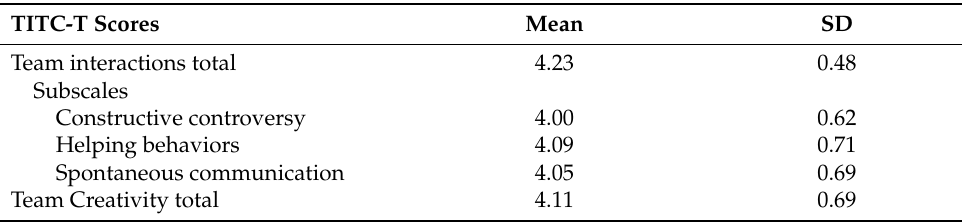
Table 2. Mean scores on the Team Interactions and Team Creativity scale for nursing students in Taiwan (TITC-T) ( n =